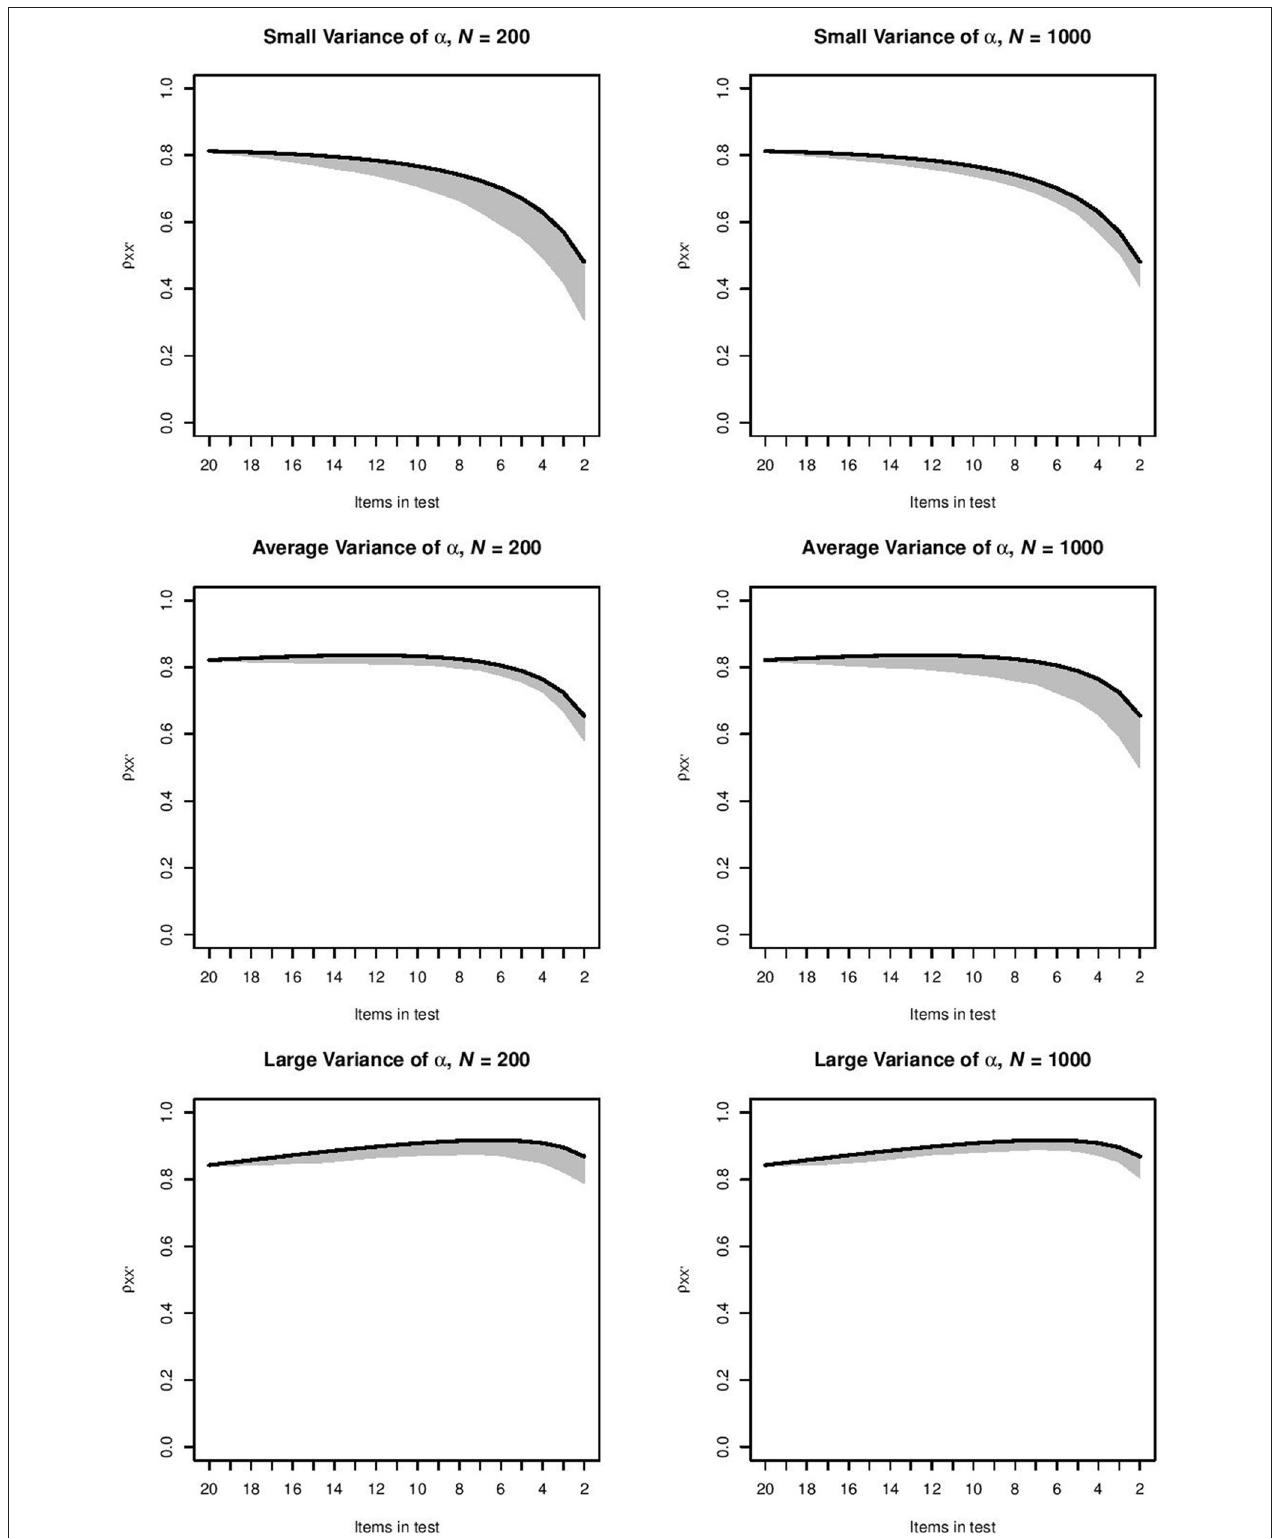
FIGURE 2 | Range of ρ XX ′ - values between the 2.5 and 97.5 percentiles of 1,000 values produced by method MS in the six conditions for the top-down procedure. The black line indicates the ρ XX ′ -value for the ideal ordering.